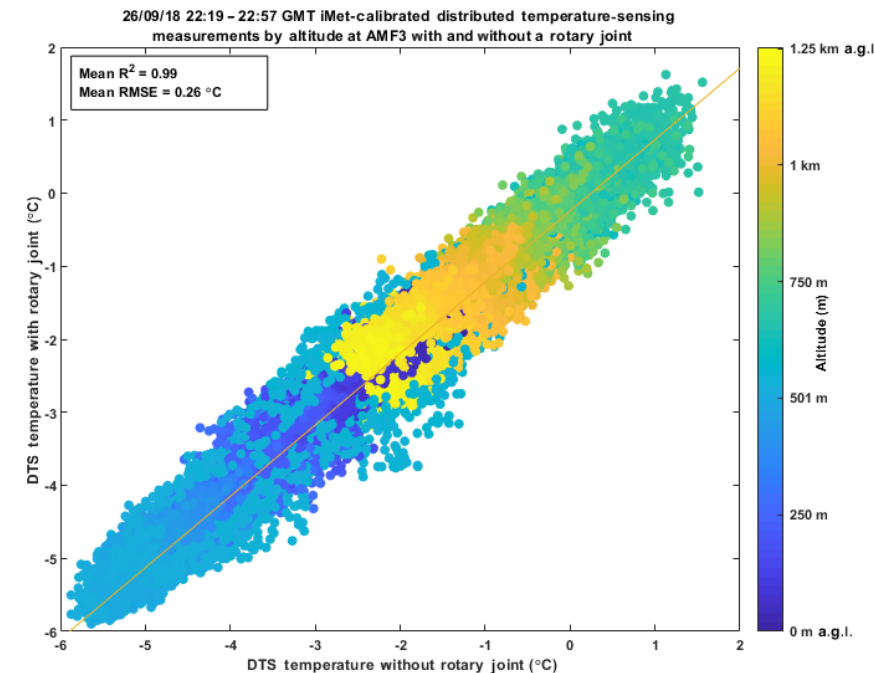
Figure 19. The 26 September 2018 TBS DTS measurements with and without a fiber optic rotary joint (FORJ).